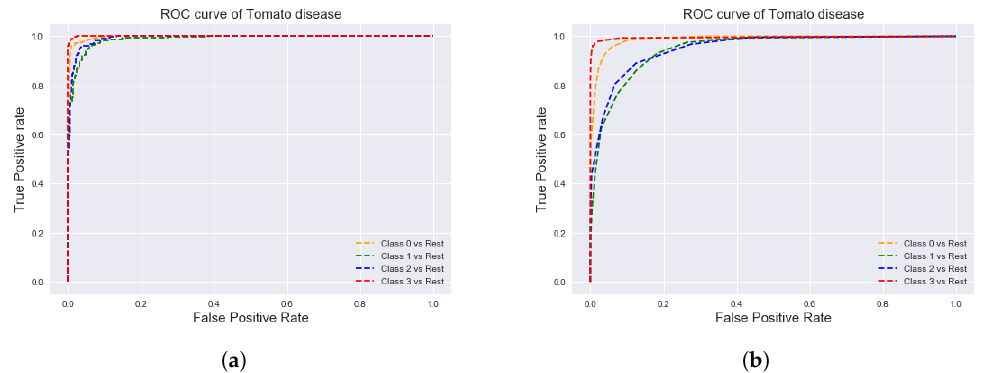
Figure 10. AUC-ROC curve of tomato diseases ( a ) shallow VGG with Xgboost ( b ) shallow VGG with RF.